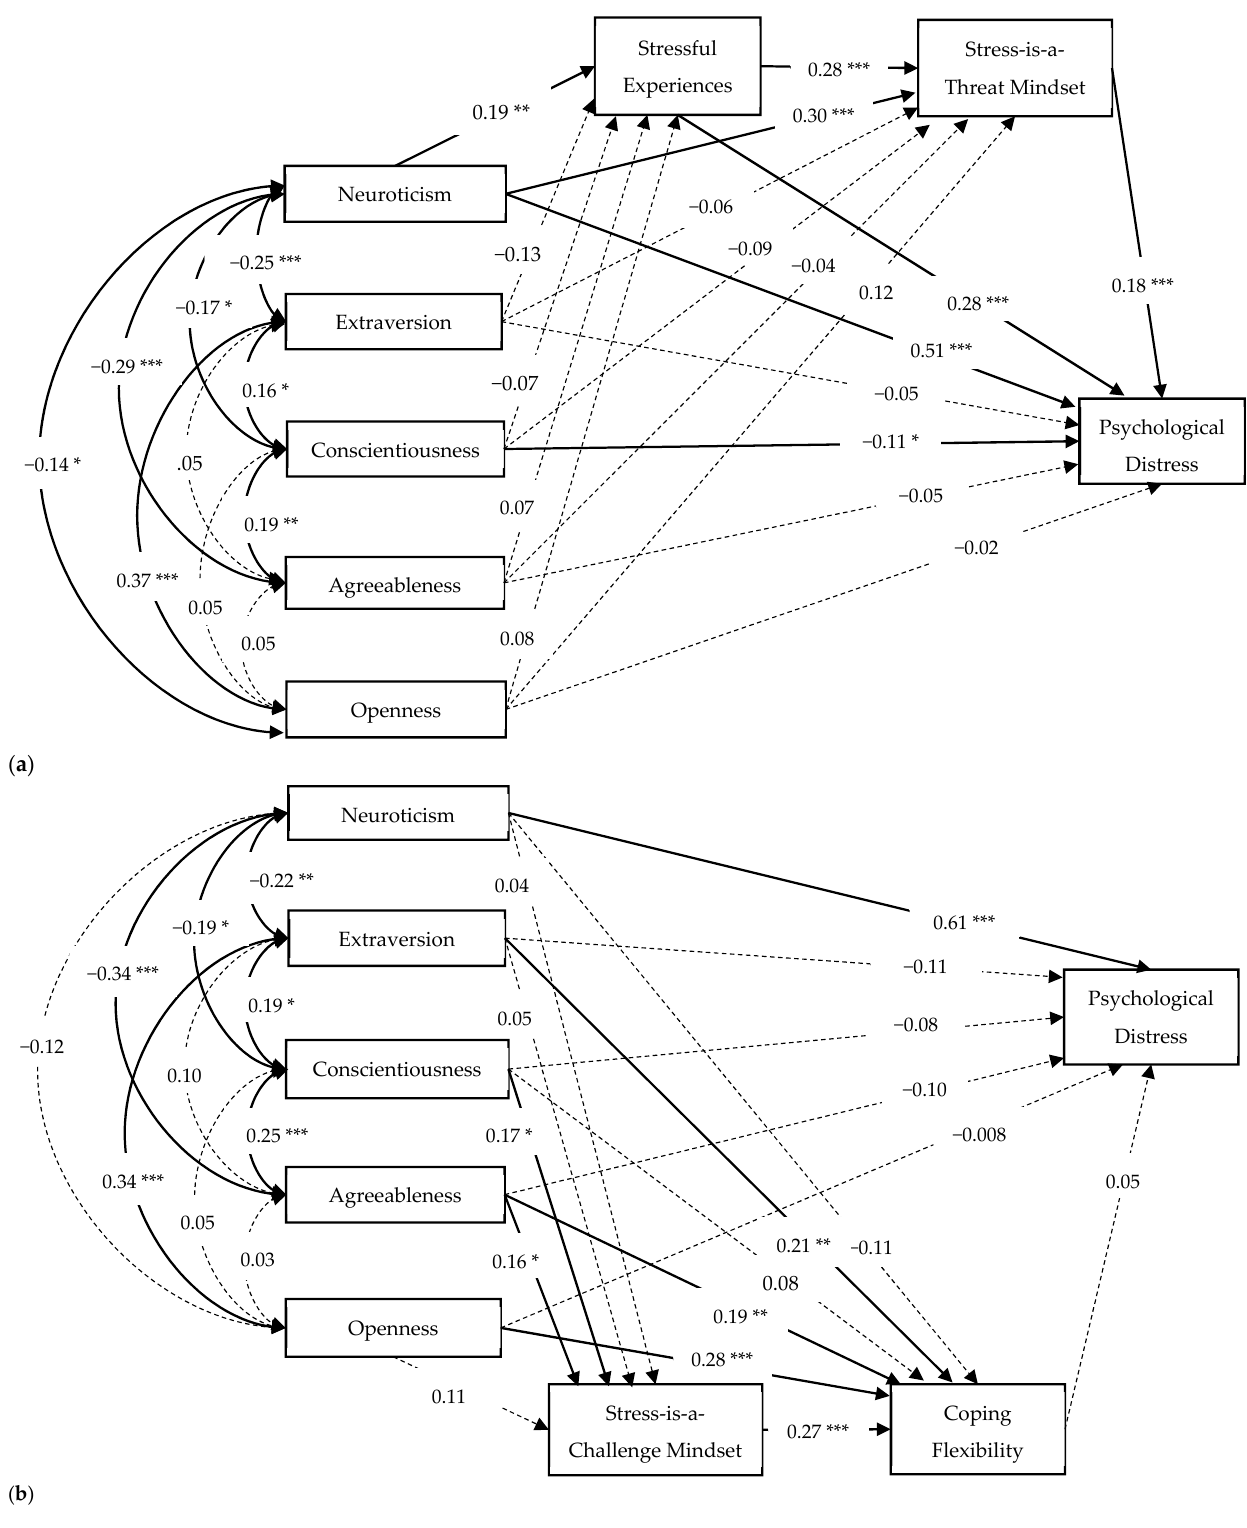
Figure 2. ( a ) The Big Five to the stress–threat–distress pathway. ( b ) The Big Five to the challenge– flexibility–enhancement pathway. Standardized coefficients are presented. Non-significant paths are denoted using dashed lines. *** p < 0.001; ** p < 0.01; * p < 0.05.